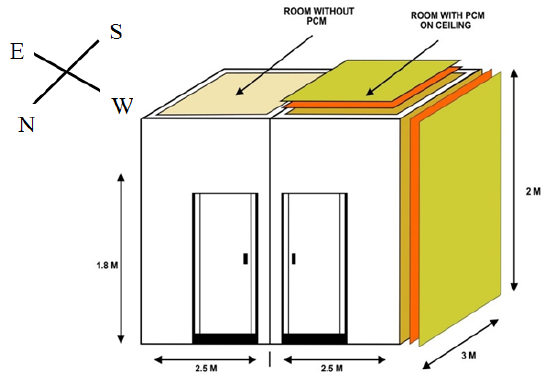
Figure 4. Geometry of the constructed test rooms, reference room (REF) ( left , without PCM) and PCM2 ( right ).